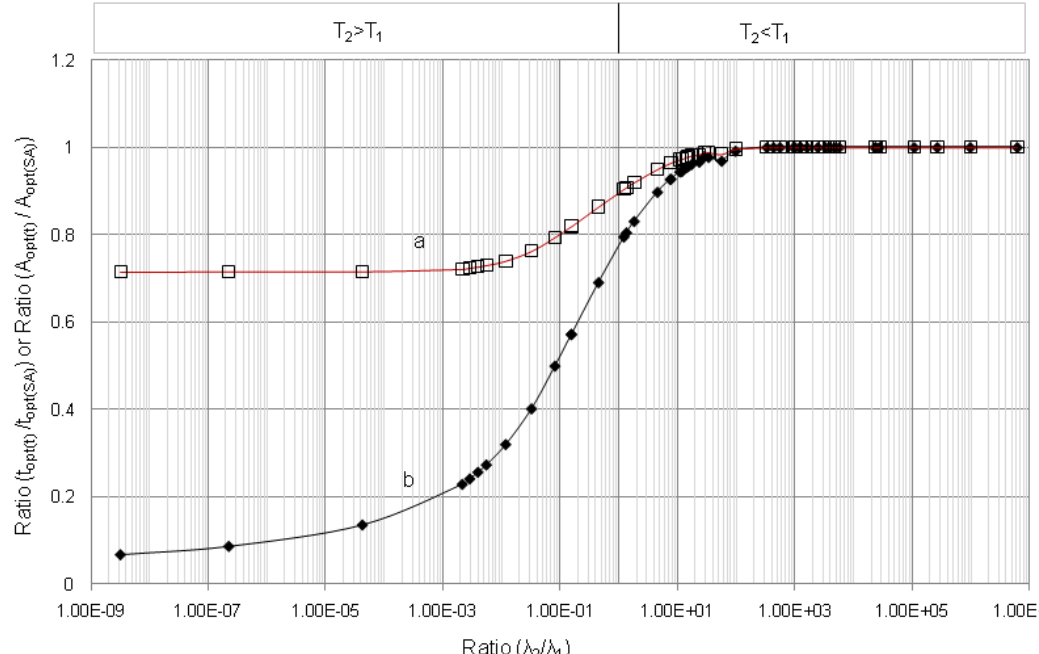
Figure 11. Ratio of optimal build-up times ( t radioactivity ( A / A ) of daughter nuclides in function of decay constant ratio 2, opt ( t ) 2, opt ( SA ) ( λ / λ ): (a) Ratio ( t / t ); (b) Ratio ( A 2 1 opt ( t ) opt ( SA ) of the parent and daughter nuclides,